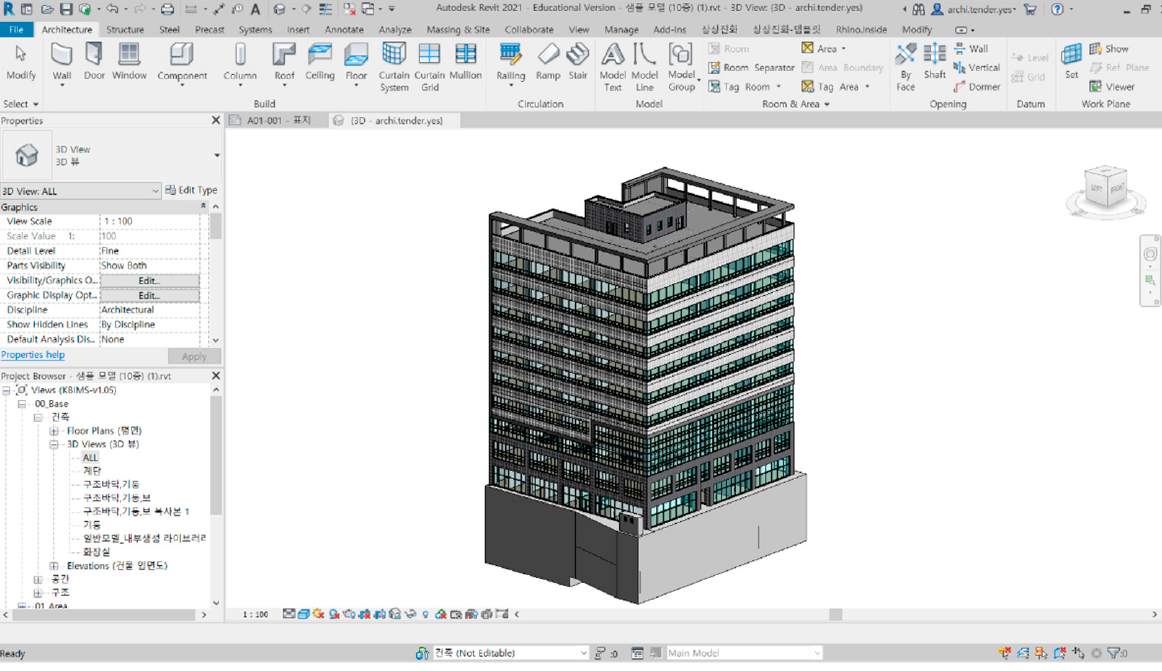
Figure 8. Test model created by Revit. The shape of the model converted to IFC is shown in Figure